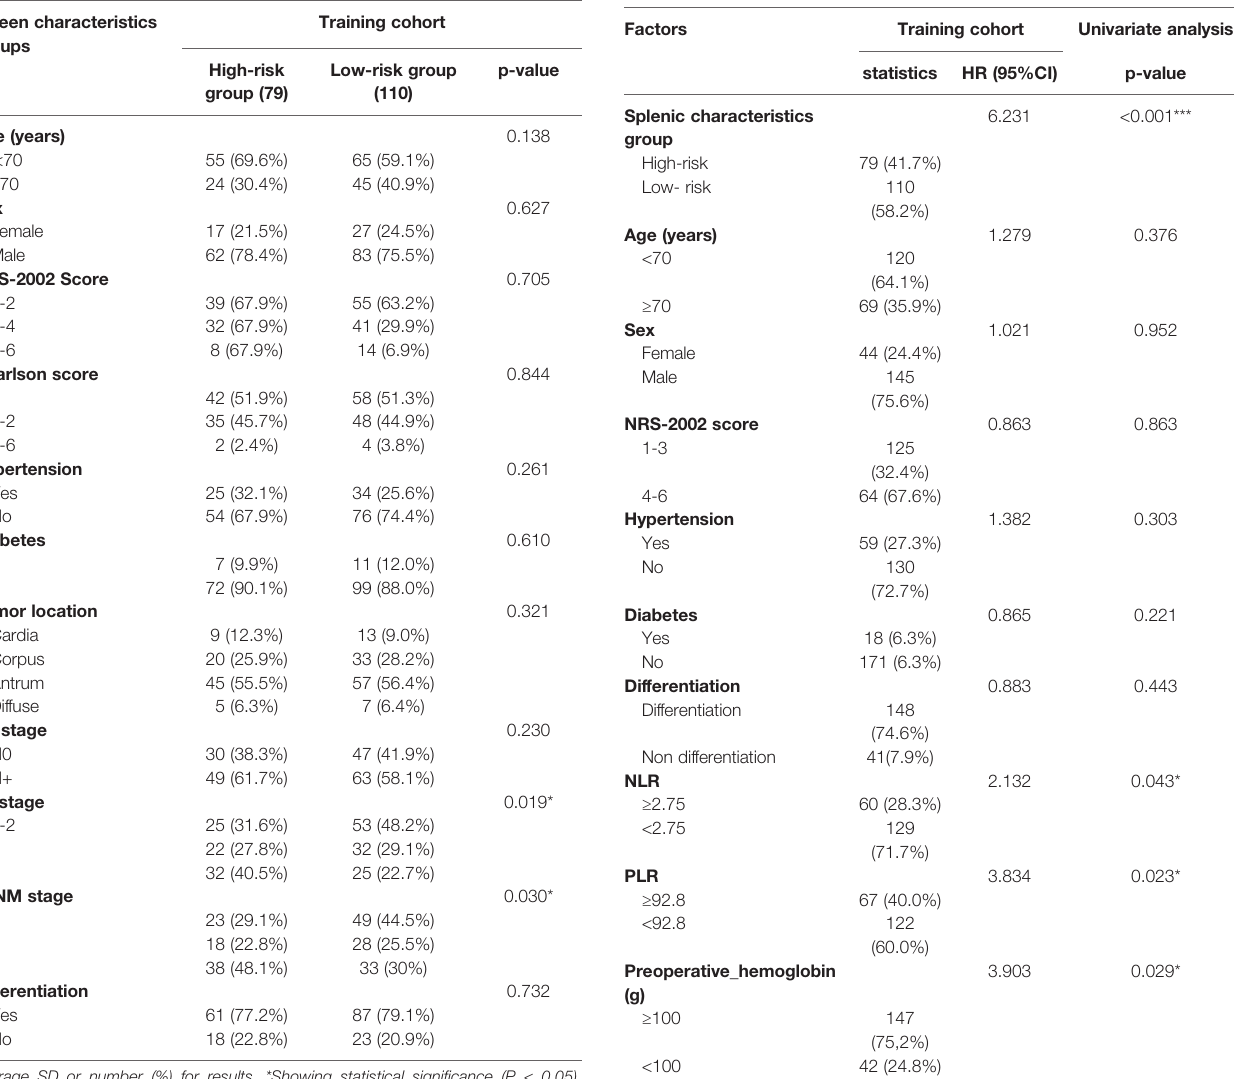
TABLE 3 | Univariate analysis table of serosal